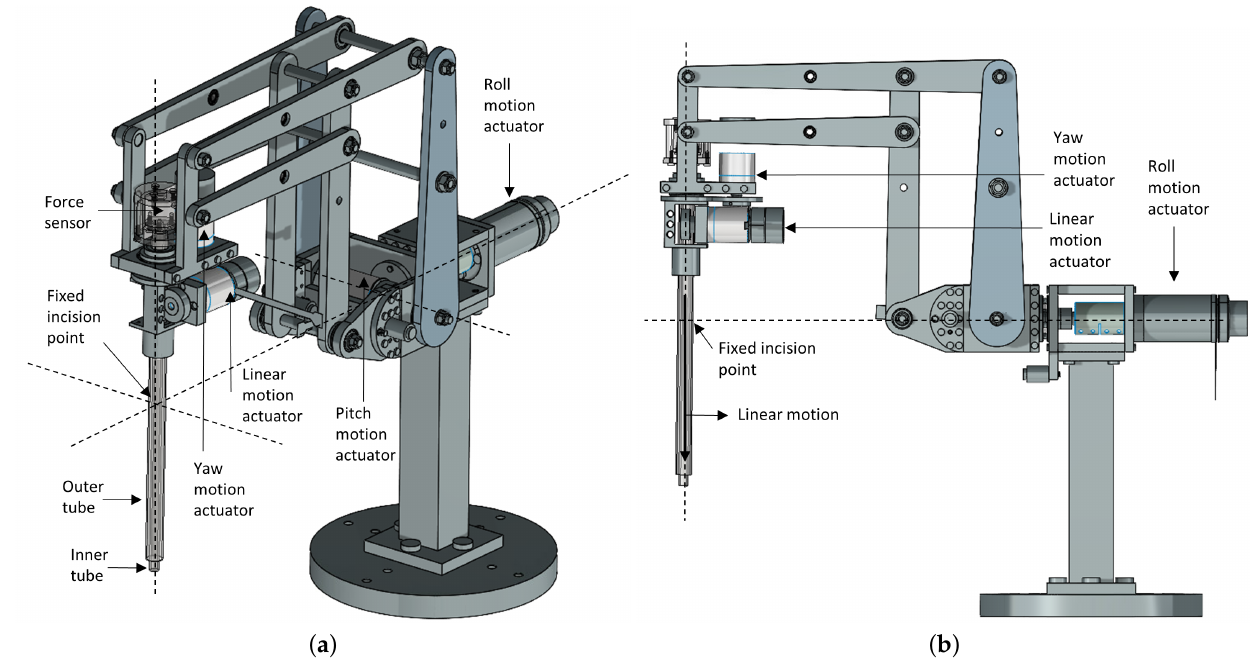
Figure 4. Slave robot with double parallelogram remote-centre-of-motion mechanism design. ( a ) The robot modules and the fixed incision point at the intersection of the robot’s axes of motion. ( b ) Side view of the robot.